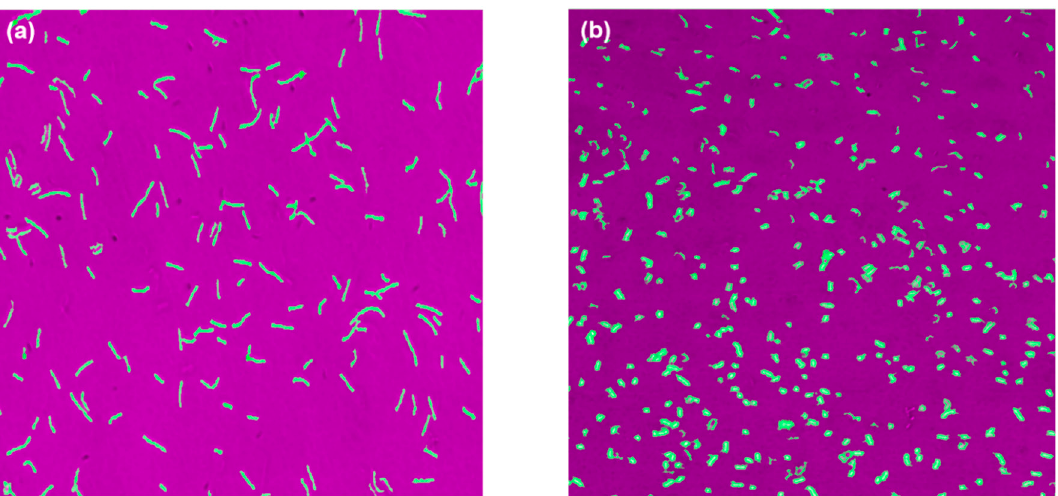
Figure 4. Automated (oCelloScope TM ) images for 10th hour samples taken from ( a ) pH-A and ( b ) pH-B.